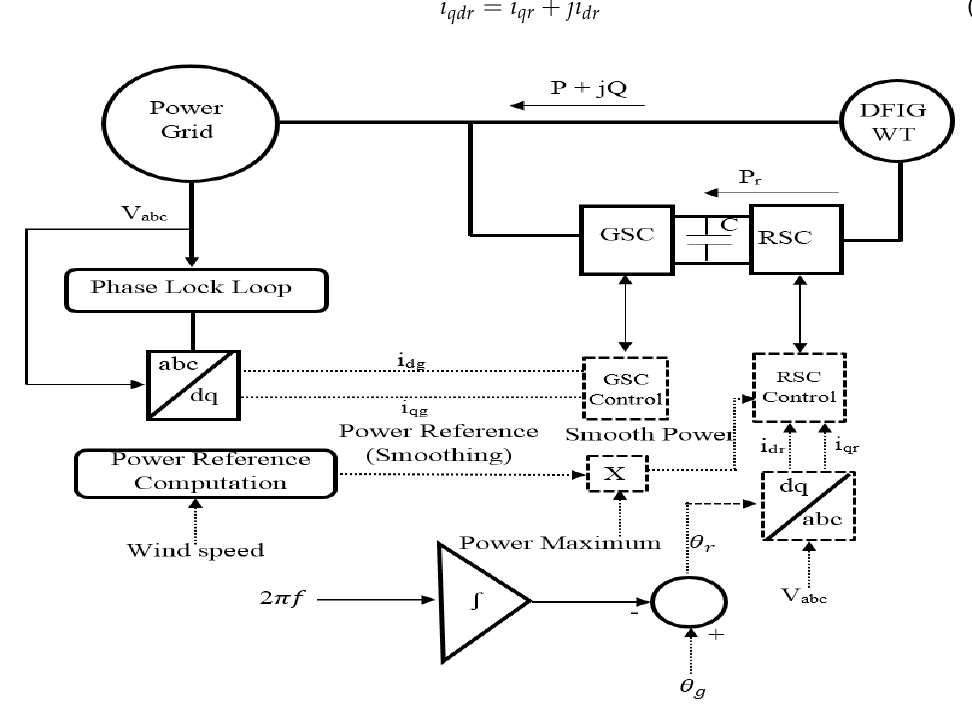
Figure 2. DFIG variable-speed